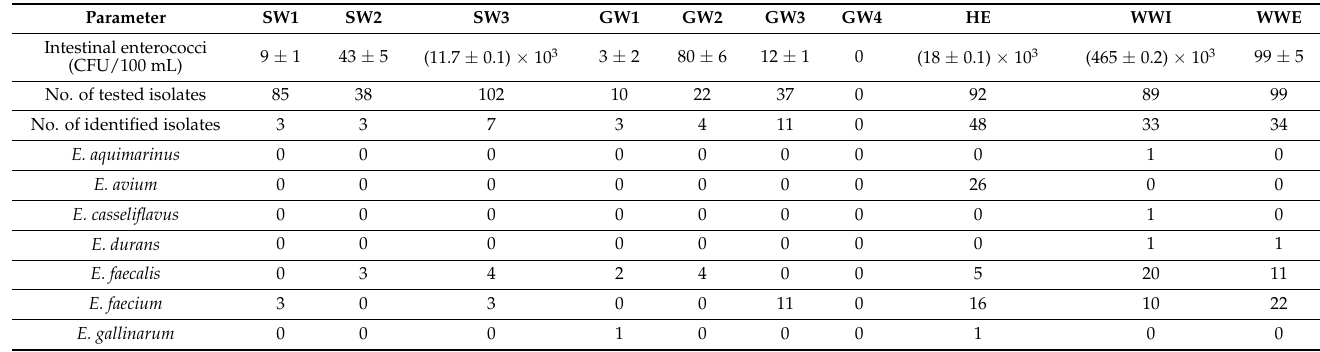
Table 1. Contamination of water by enterococci along the aquatic